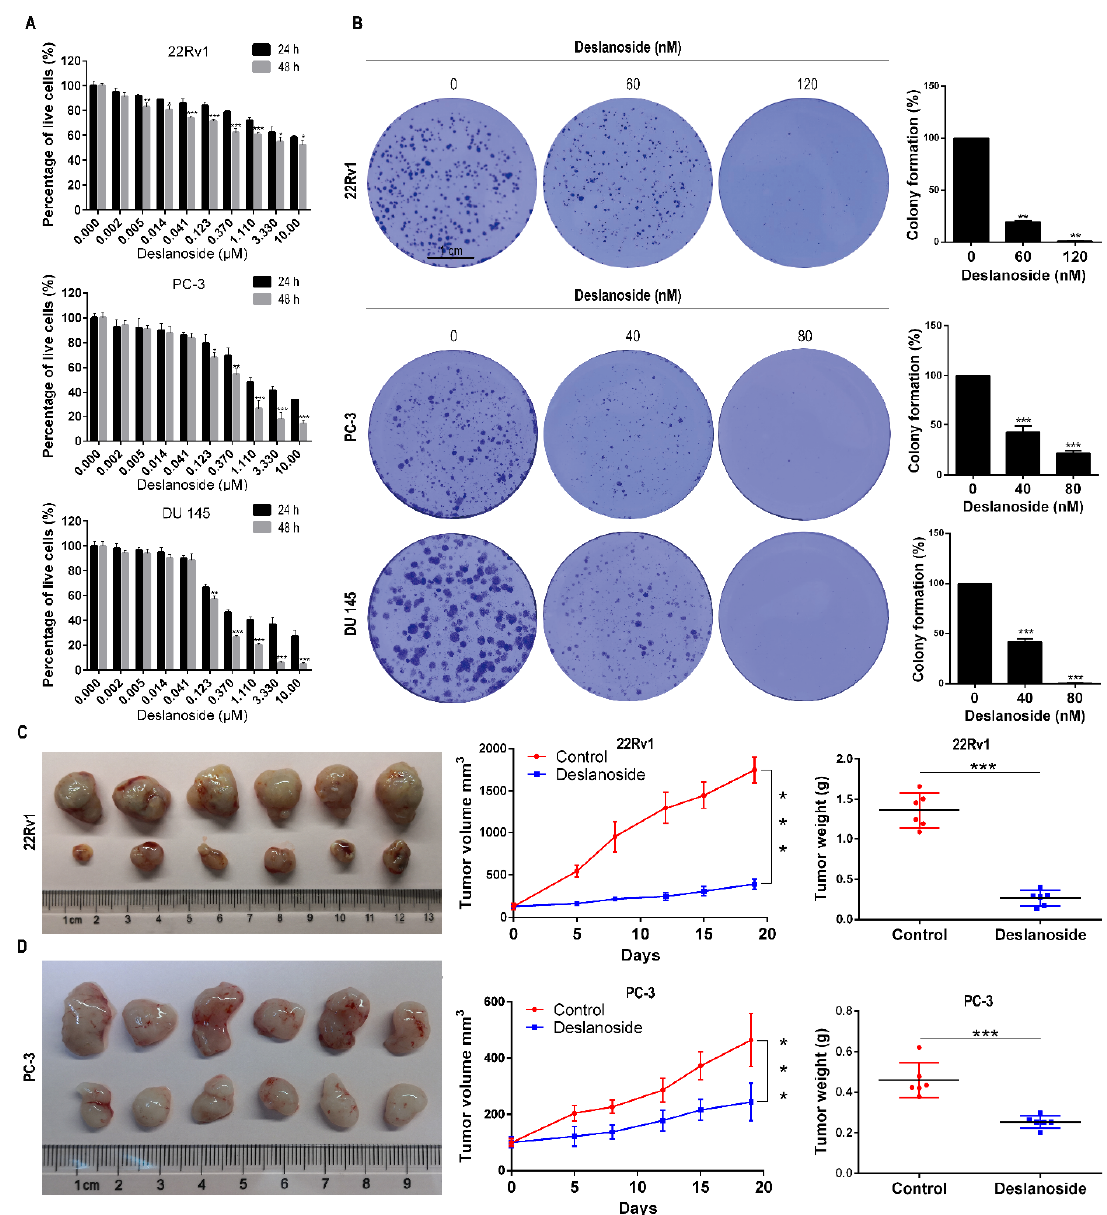
Figure 1. Deslanoside exerts anticancer activity in prostate cancers cells. ( A ) Deslanoside decreases cell viability in 22Rv1, PC-3, and DU 145 PCa cell lines, as determined by the CCK-8 assay in cells treated with indicated concentrations for 24 or 48 h. ( B ) Deslanoside reduced colony formation in the same 3 cell lines, as analyzed by the colony formation assay in cells treated with indicated concentrations for 13 days (22Rv1) or 10 days (PC-3 and DU 145). Scale bars, 1 cm. ( C , D ) Deslanoside attenuated tumor growth of 22Rv1 ( C ) and PC-3 ( D ) cells in nude mice, as indicated by tumor images (left), tumor volumes at indicated days (middle), and tumor weights at surgical isolation (right). An unpaired t -test was used to determine the statistical significance. All values are presented as mean ± SD. n = 6 for each group. * p < 0.05, ** p < 0.01; *** p < 0.001.